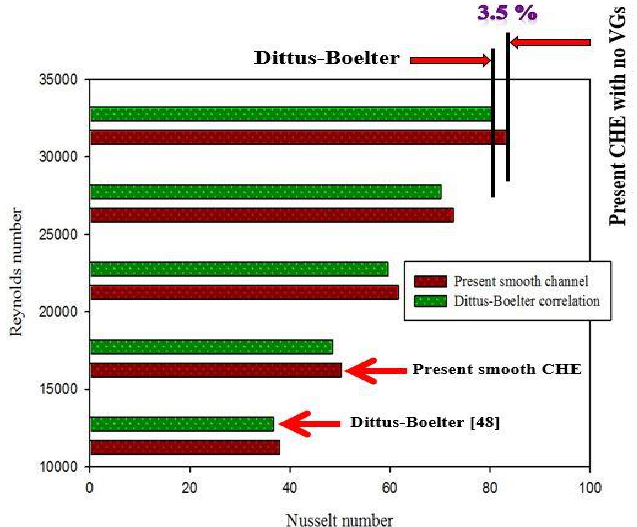
Figure 3. Nu values for an unbaffled